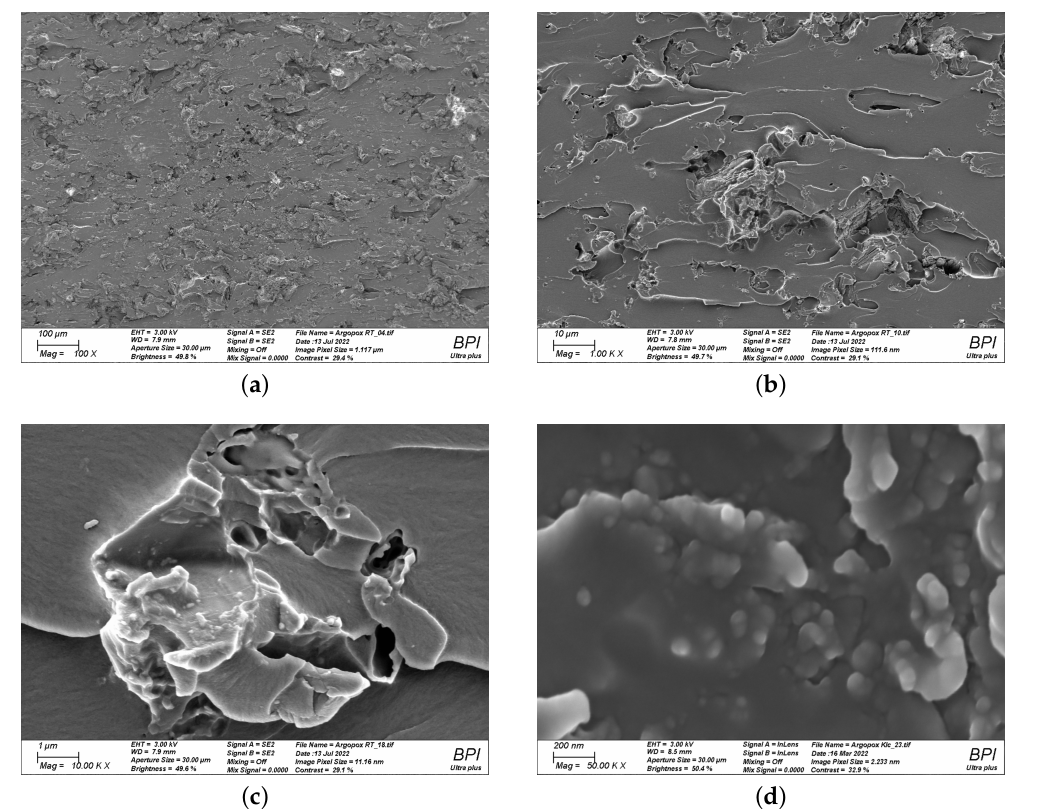
Figure 8. Scanning electron microscopy images of cured Argopox-1 at 100 × ( a ); 1000 × ( b ); 10,000 × ( c ); and 50,000 × magnification ( d ) showing the fracture surface of the cured thermoset and the nanometer- sized L -arginine